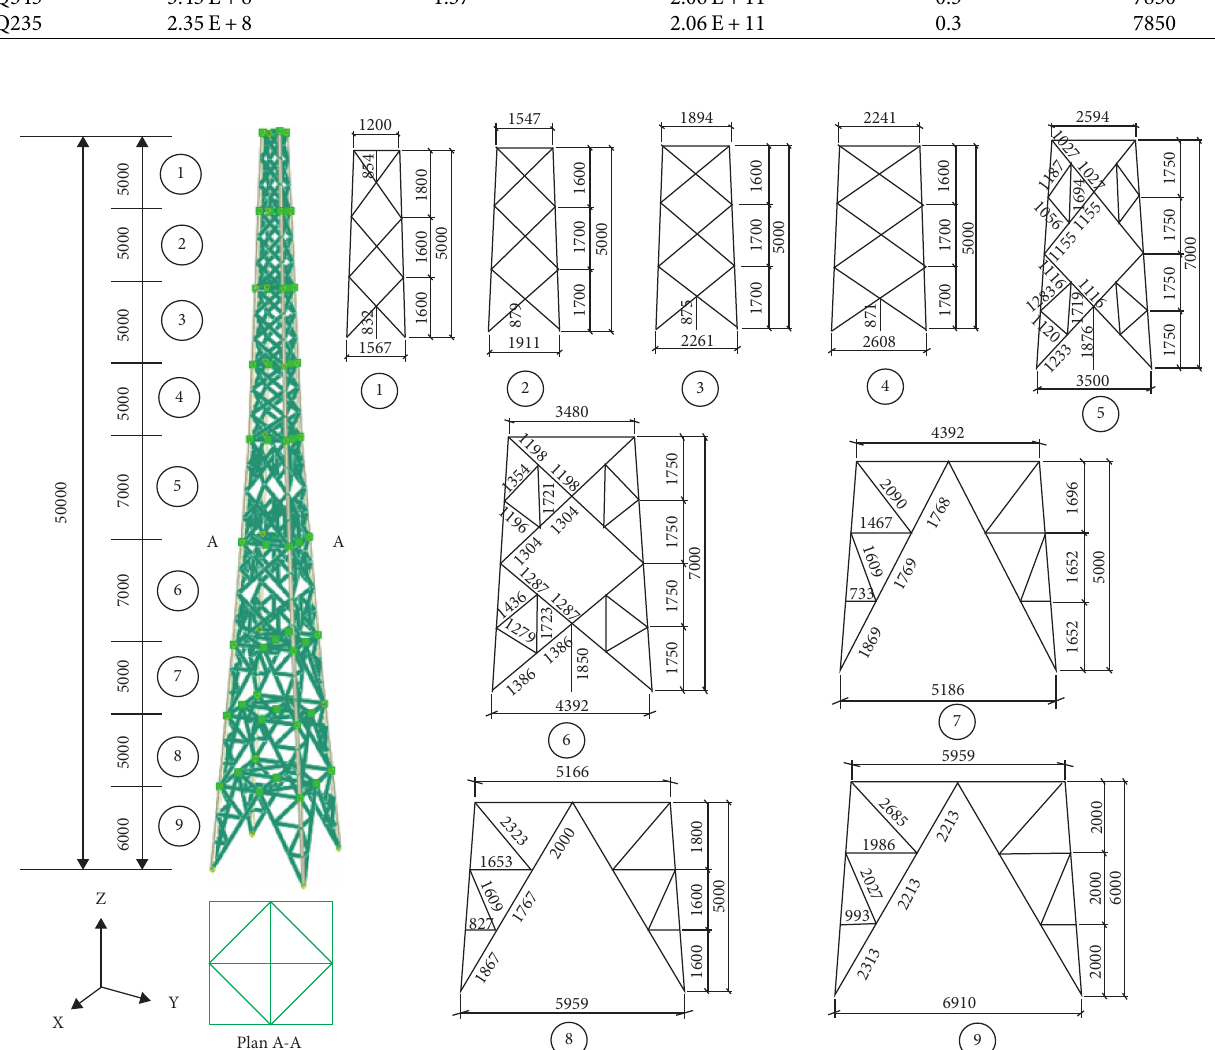
Figure 1: Sketch of the prototype Structure (unit: